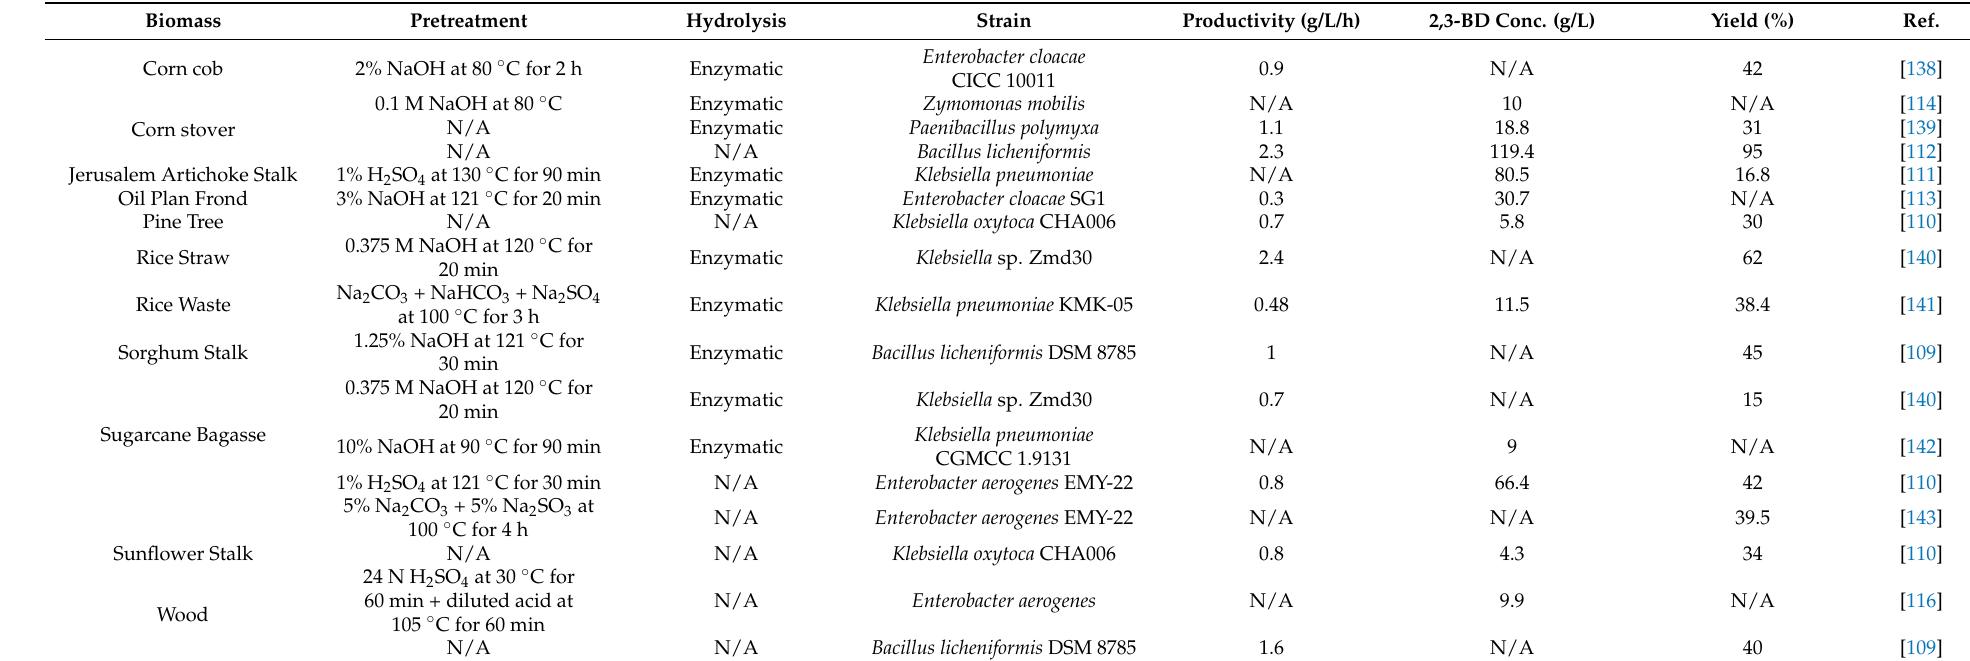
Table 8. Review of fermentation methods for 2,3-butanediol (2,3-BD) from